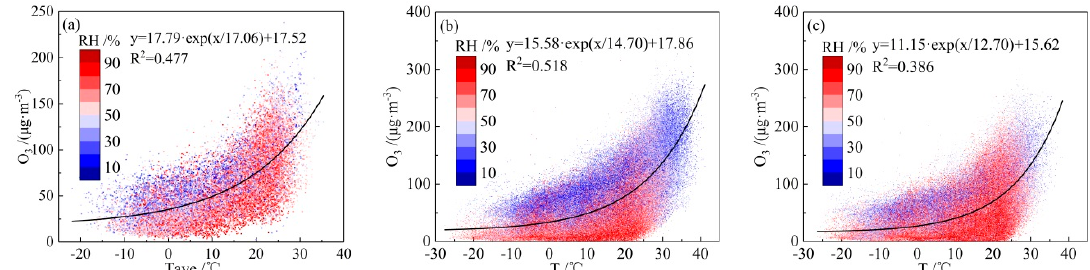
Figure 9. The scatter plot and fitted curve between daily mean O 3 mass concentrations and daily average temperatures ( a ), and the scatter plots and fitted curves between O 3 mass concentrations and daytime temperatures ( b ), nighttime temperatures ( c ) under different relative humidity (RH, %).